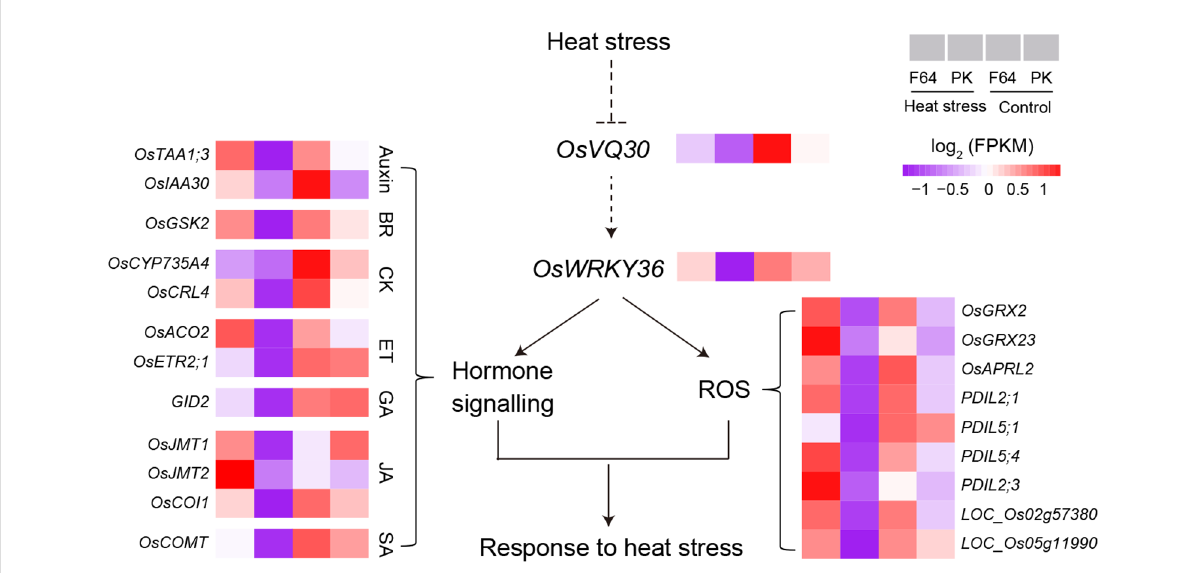
FIGURE 5 Hypothetical model of qHT7 responses to high-temperature stress in rice. The model is proposed based on the genome and transcriptome analysis in this study. A complete list of genes is shown in Supplementary Table